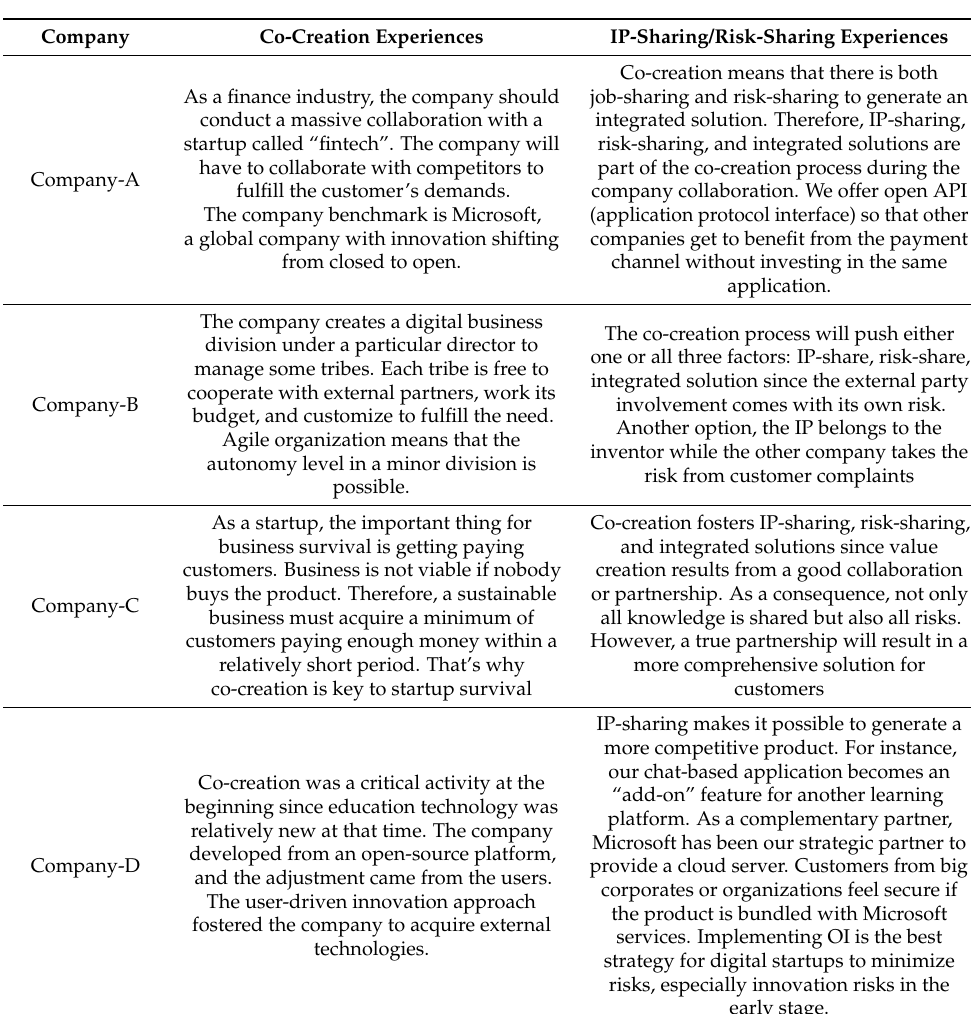
Table 3. OI factors for Digital